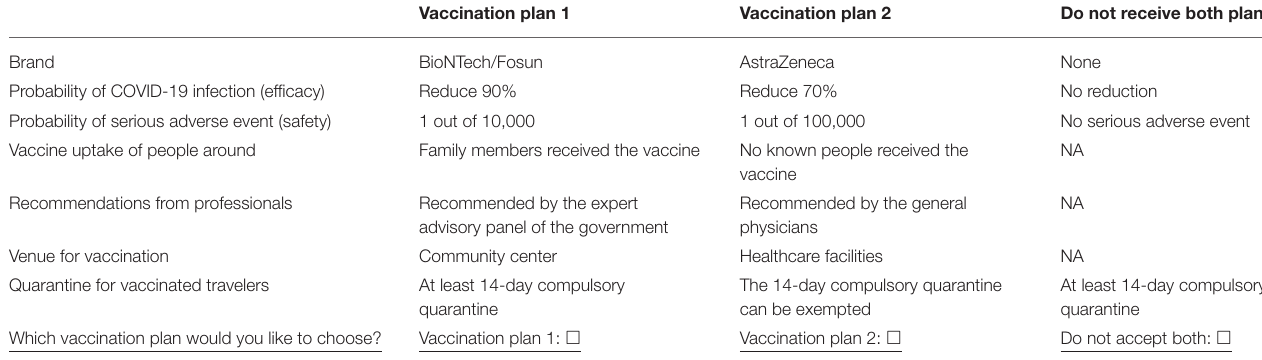
TABLE 2 | Example of the choice sets in the